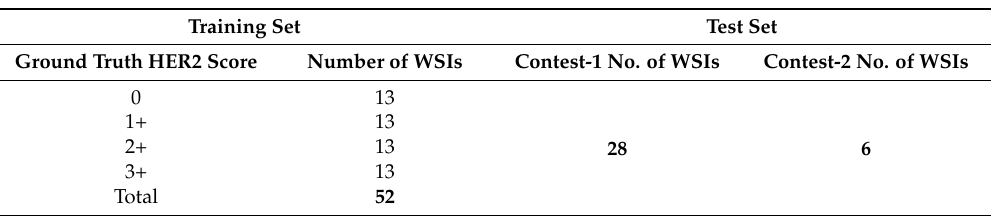
Table 2. Number of WSIs provided for training and testing the classification algorithm. Reproduced from [12] with permission.